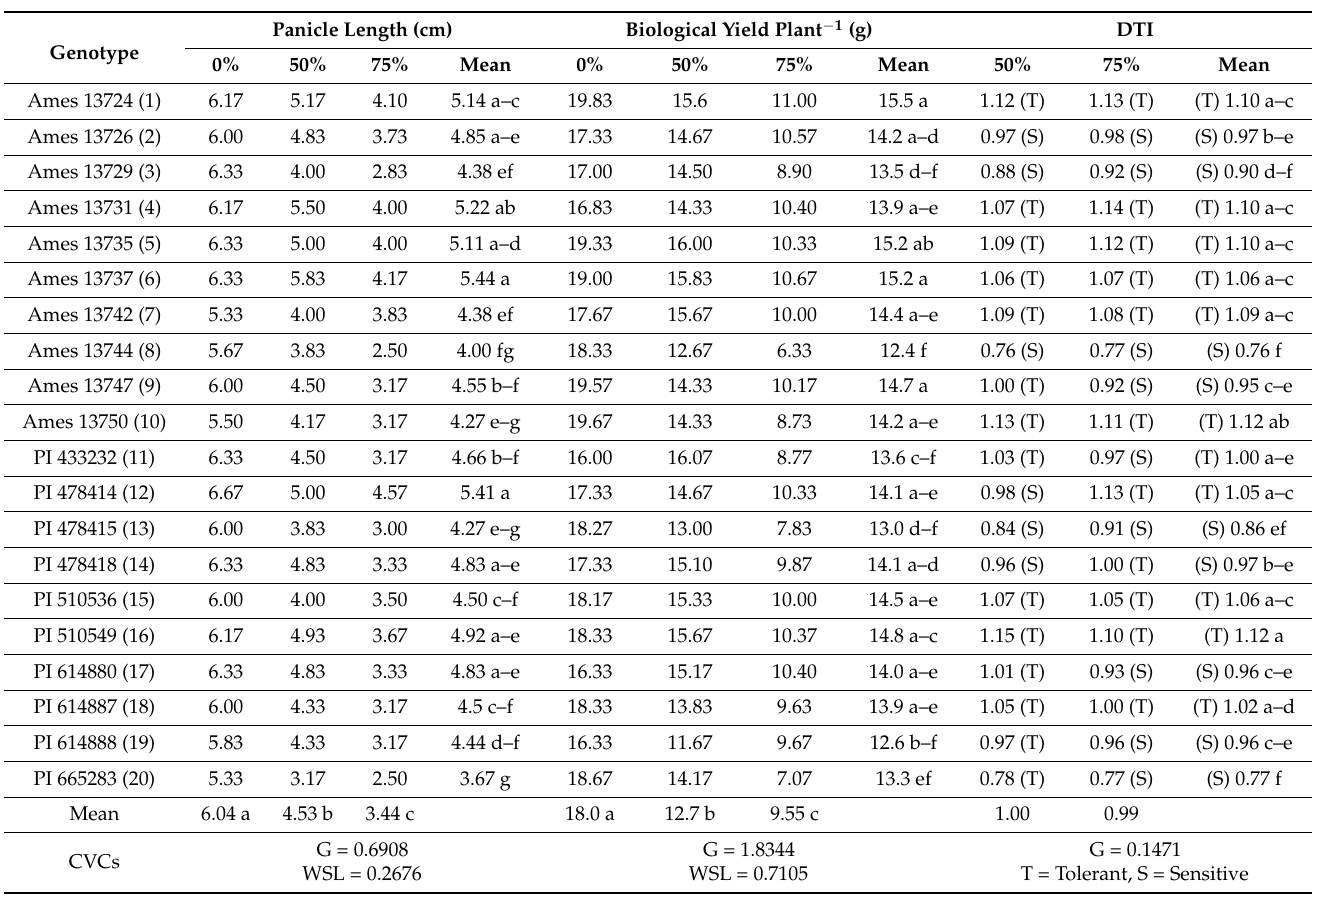
Table 5. Yield parameters of quinoa genotypes and drought tolerance index (DTI) based on seed yield under water deficit